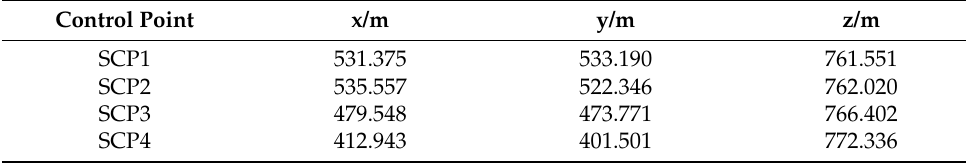
Table 4. The coordinates of control points.